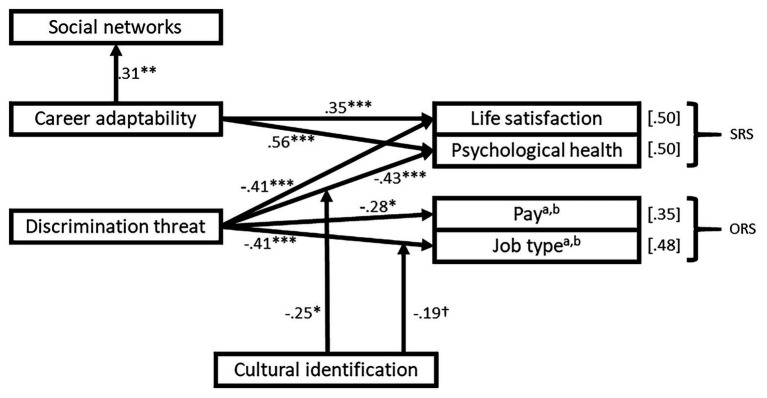
Model of resettlement success for Venezuelans in Colombia. SRS, subjective resettlement success; ORS, objective resettlement success. Control variables: aGender (0.19* for job type, 0.21* for pay), bEducation (0.43*** for job type, 0.44*** for pay). †p < 0.10, *p < 0.05, **p < 0.01, and ***p < 0.001. R2 values are enclosed in brackets for each outcome variable.